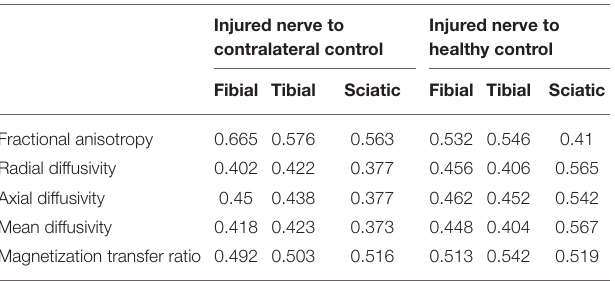
TABLE 3 | Area under the curve.